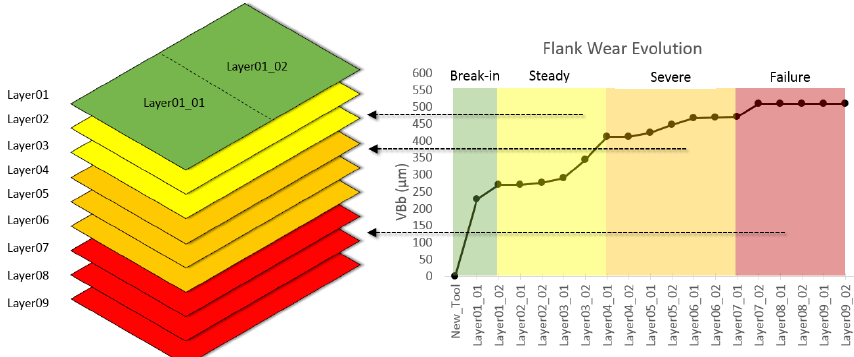
Figure 7. Mapping between the evolution of the tool flank wear across the Break-in , Steady , Severe and Failure classes (right-hand side) to the nine layers (left-hand side).